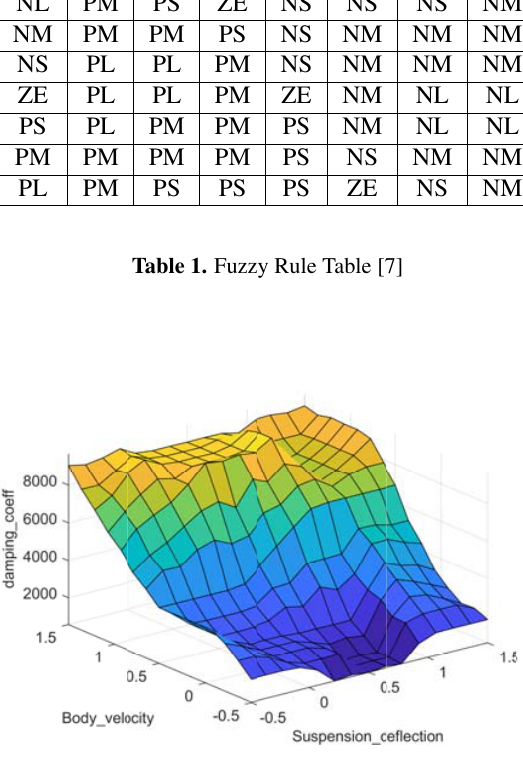
Figure 7. Surface view of Fuzzy i / p vs o / p